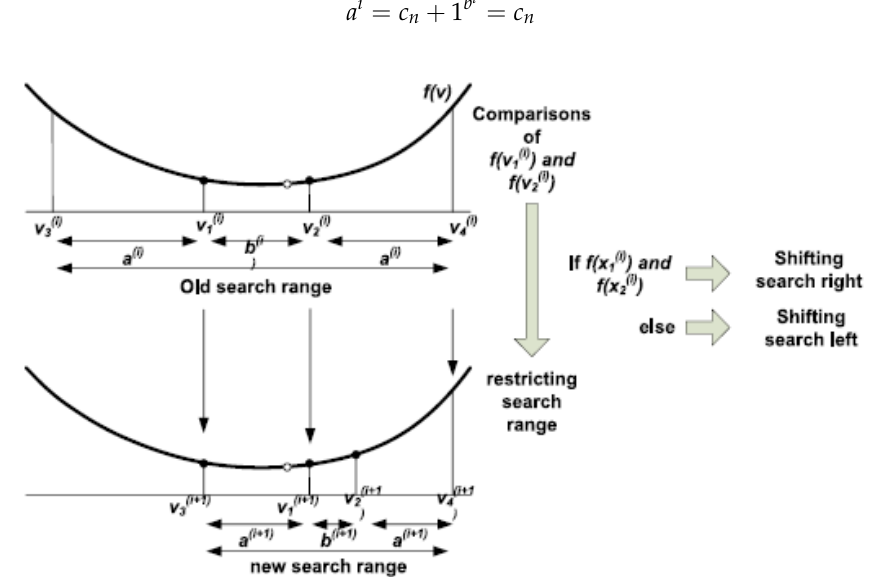
Figure 20. Fibonacci search technique searching process [80].